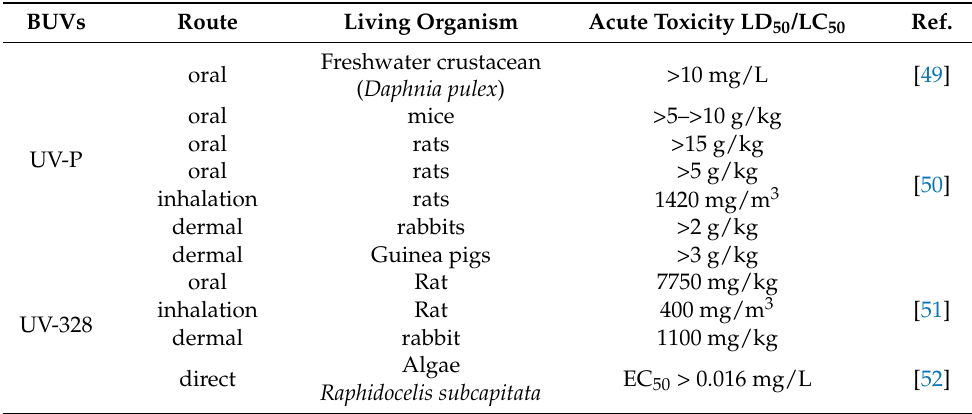
Table 2. Acute toxicity of selected benzotriazoles on living organisms. BUVs Route Living Organism Acute Toxicity LD 50 /LC 50